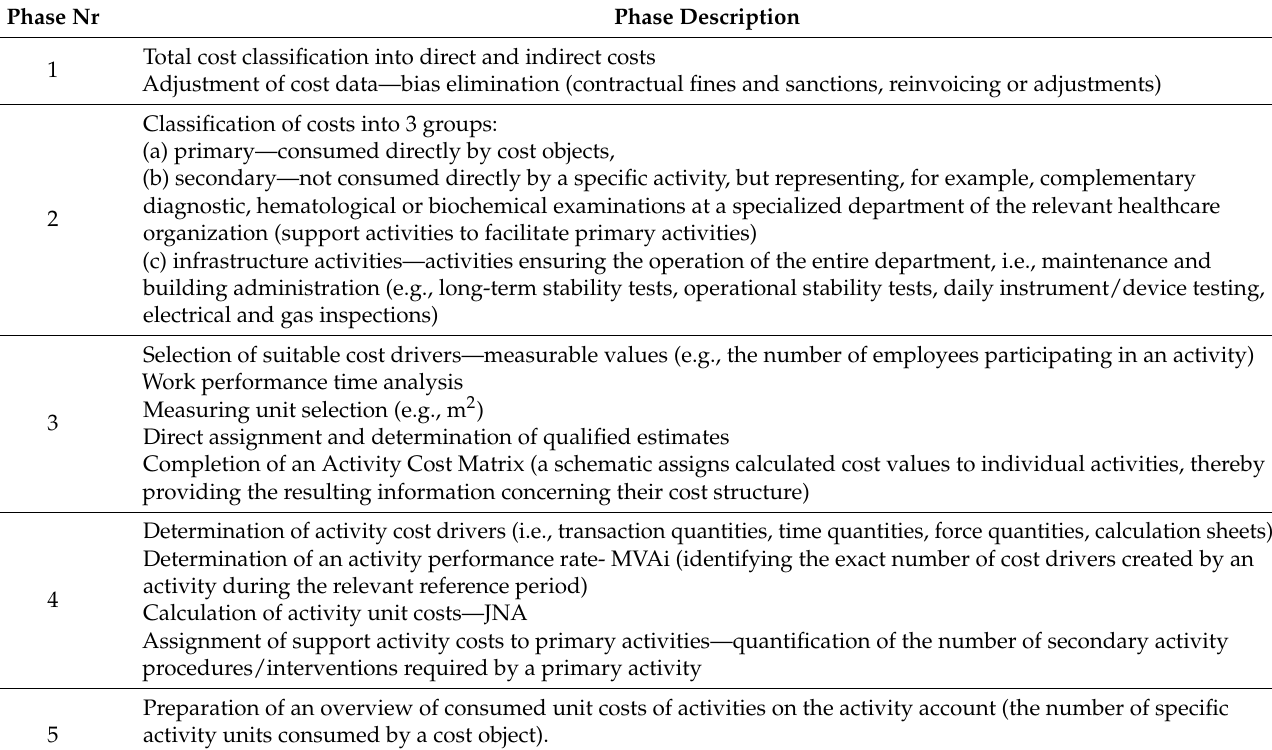
Table 3. Description of the ABC method component